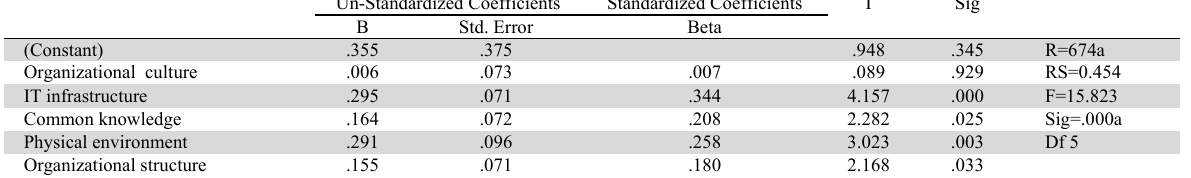
Results of the Multiple Regression Analysis for KM Infrastructure in the Company´s Innovation Process and Products